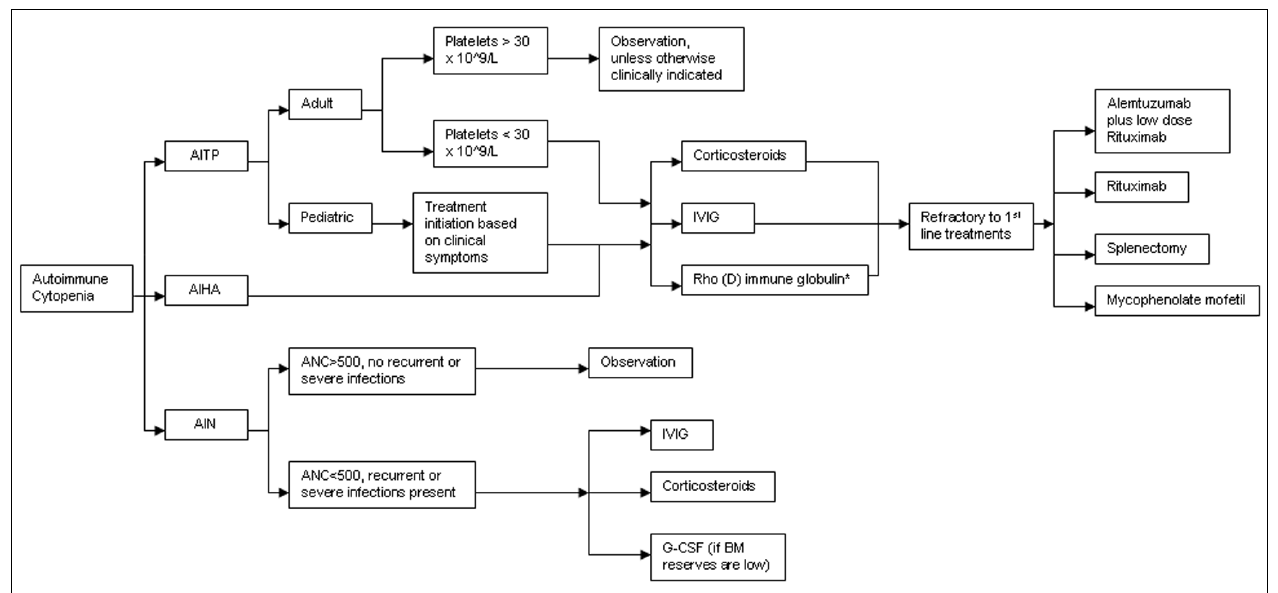
FIGURE 2 |Treatment algorithm for autoimmune cytopenias in CVID. AITP, autoimmune thrombocytopenia; AIHA, autoimmune hemolytic anemia; AIN, autoneutropenia; IVIG, intravenous immunoglobulin; ANC, absolute neutrophil count; G-CSF, granulocyte colony stimulating factor. *Rh+, non-splenectomized individuals